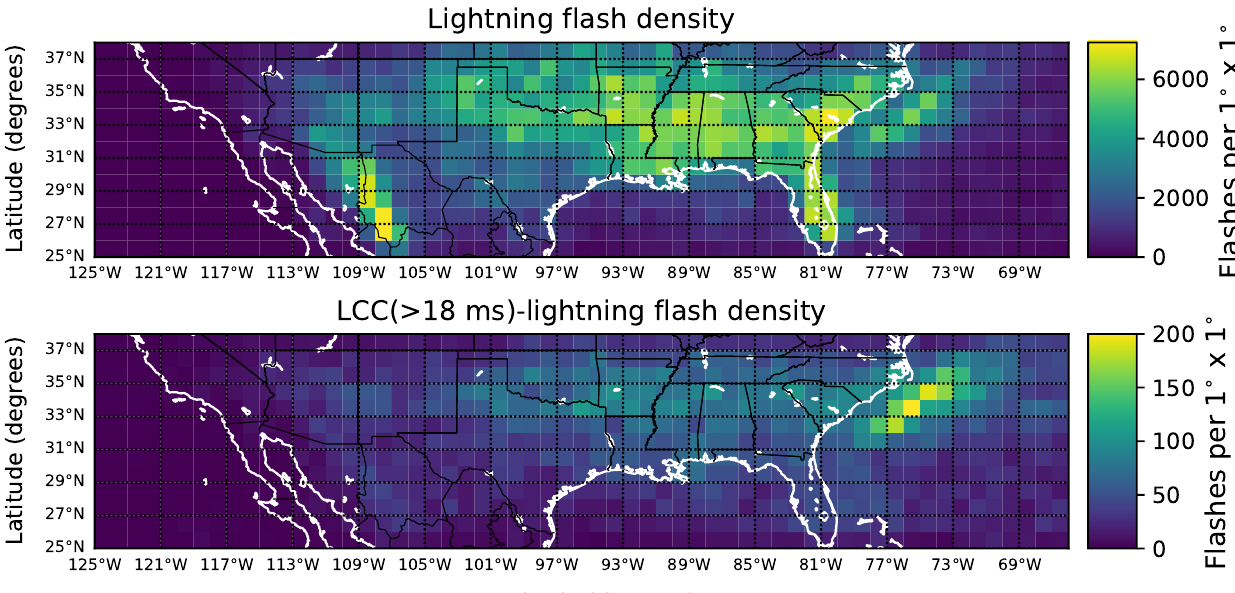
Figure 8. Flash densities for lightning ( top panel ) and LCC ( > 18 ms) lightning ( bottom panel ) between May and September 1998–2014, obtained from TRMM-LIS lightning